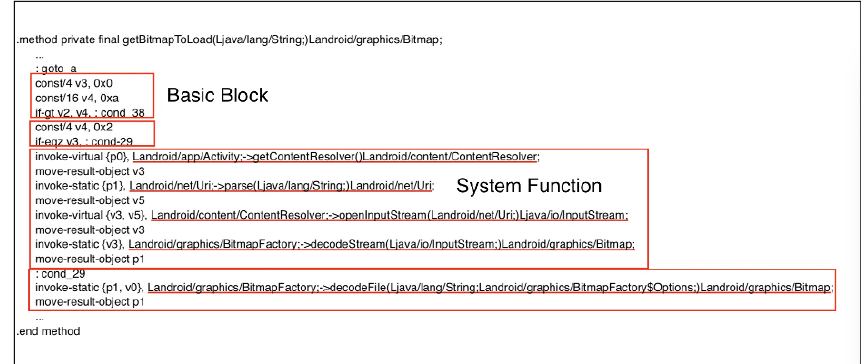
Figure 7. Basic block and system function called in the smali file.